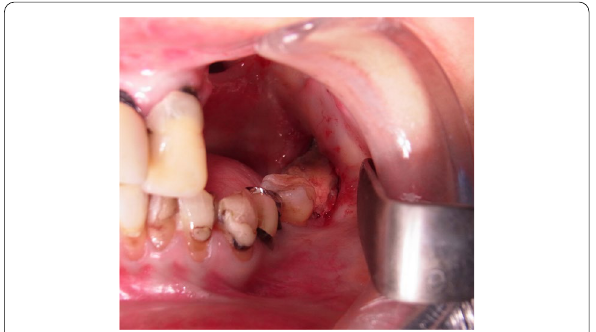
Fig. 1 Clinical presentation, intraoral view. Exposed necrotic bone was found on the left mandible